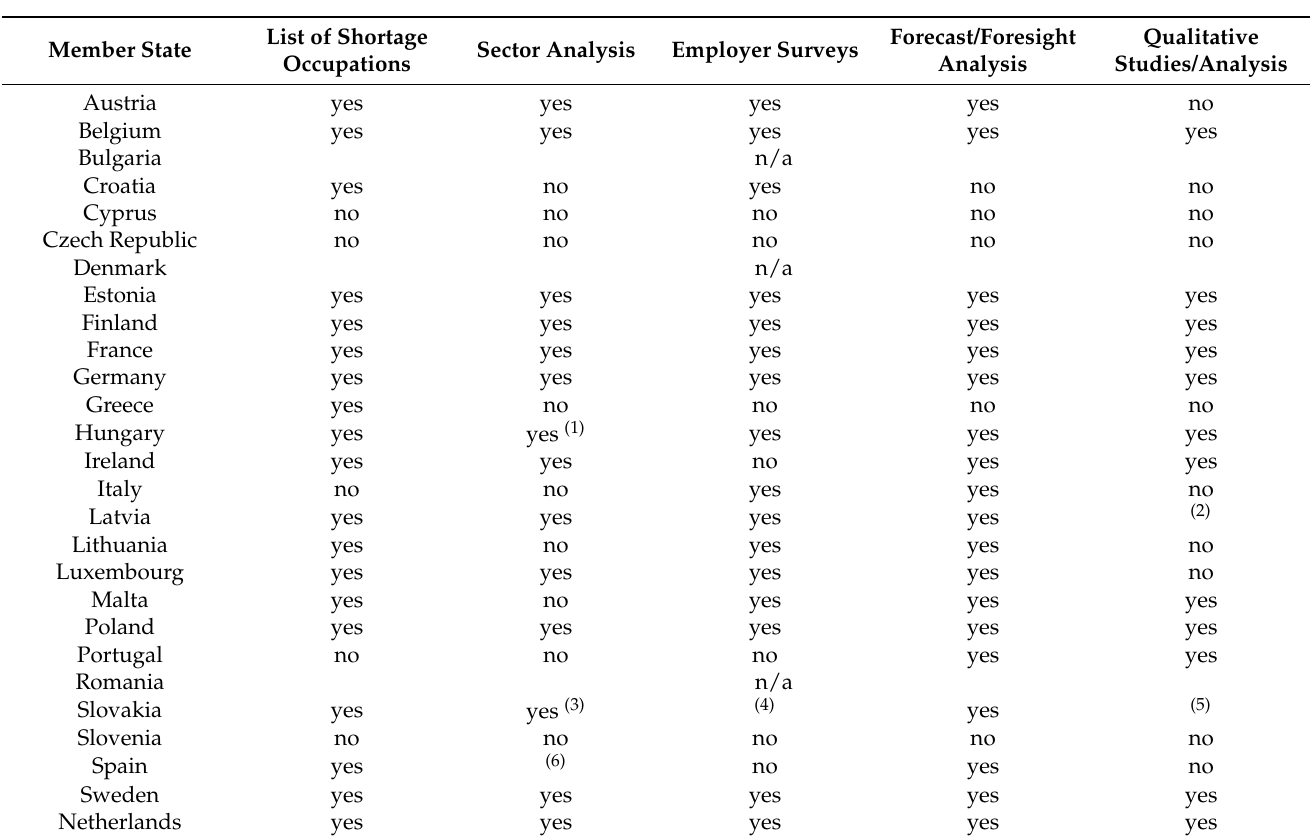
Table 2. Instruments for identifying labour shortages used by each Member State (the table is structured by authors upon open-source data collected data